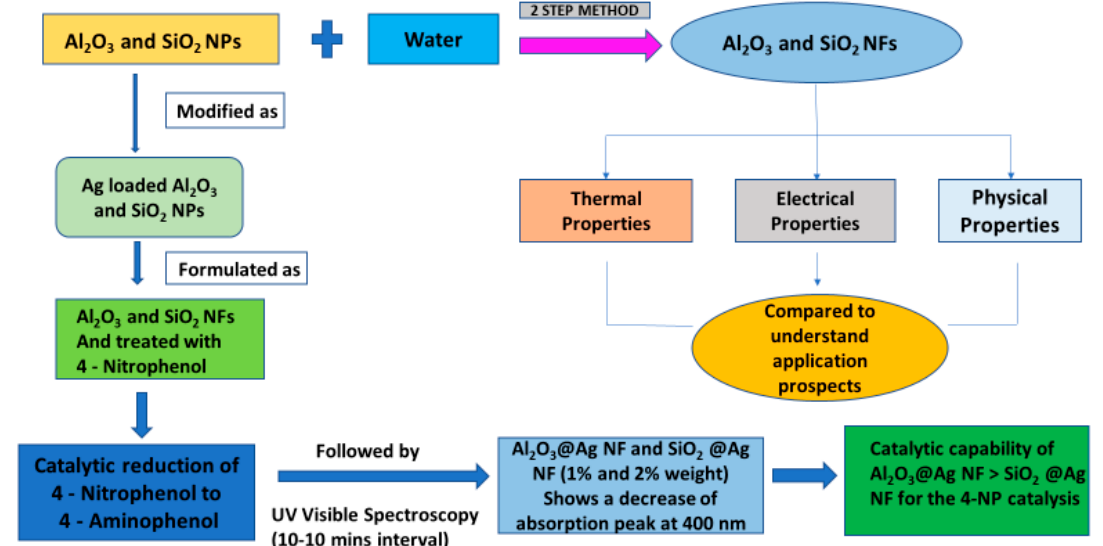
Scheme 1. Stages involved in the preparation of nanofluids based on silver encapsulated alumina/silica, evaluation of properties, and catalytic properties, and catalytic application.